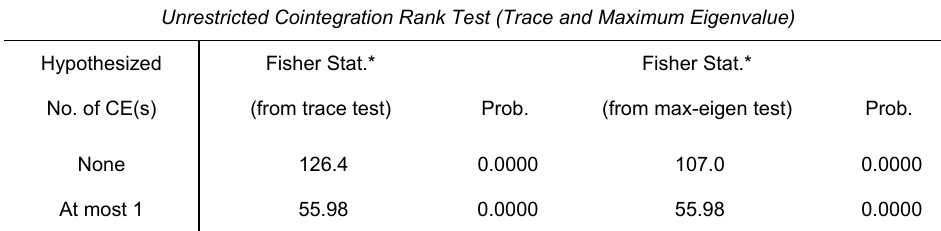
Table 7: Johansen Fisher Panel Cointegration Test Unrestricted Cointegration Rank Test (Trace and Maximum Eigenvalue) Hypothesized Fisher